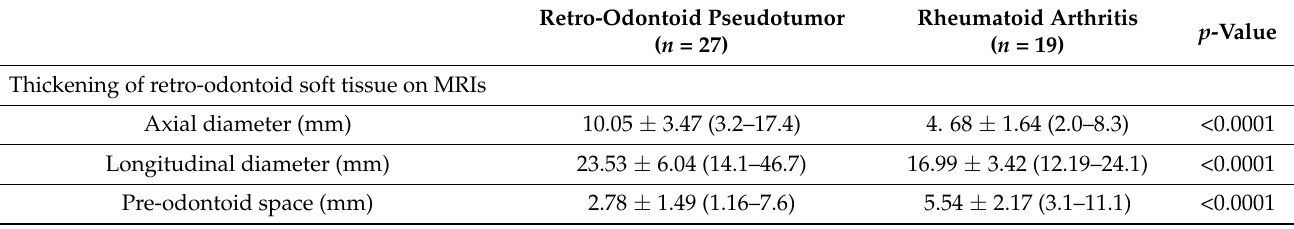
Table 2. Measurements of retro-odontoid soft-tissue thickness and pre- and retro-odontoid space on MRIs and atlantoaxial instability on CT